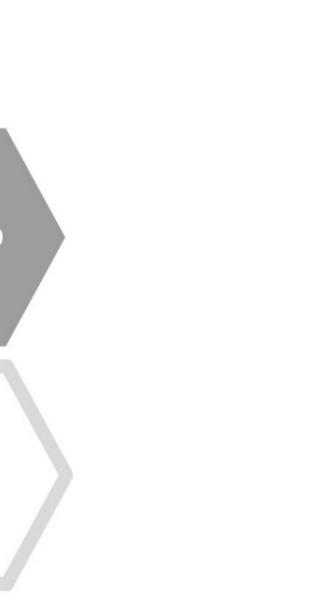
Figure 5. Block diagram of the techniques utilized for the growth of non-polar GaN-based photodetectors.